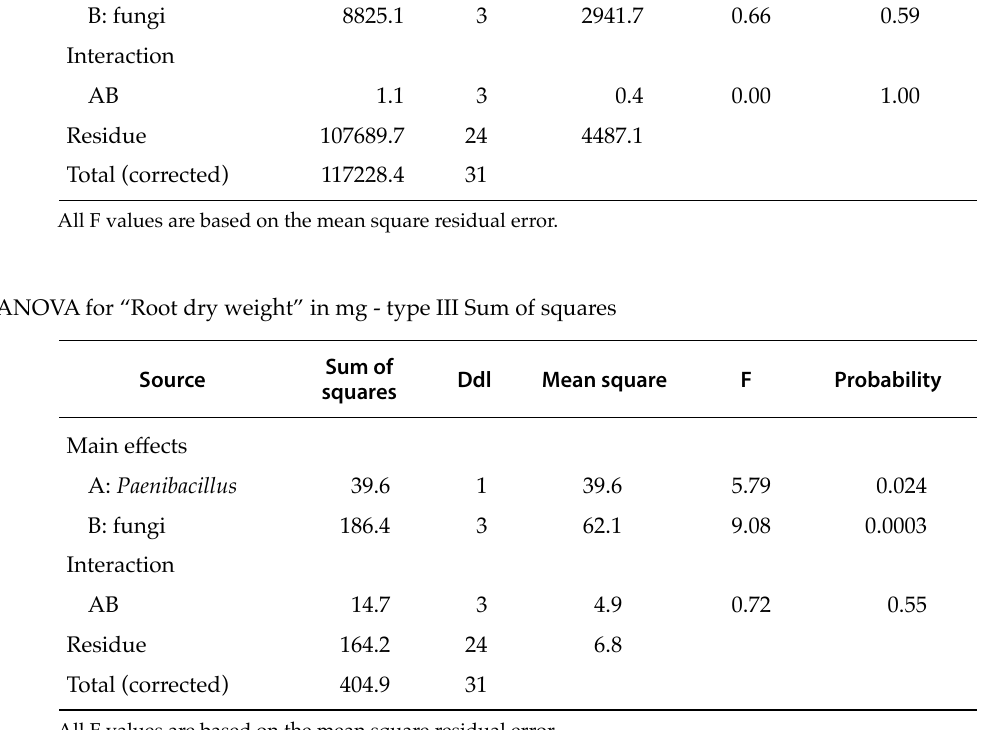
Table 5. ANOVA for “Shoot fresh weight” in mg - type III Sum of squares Sum of Ddl Mean square F Probability Source squares Main effects